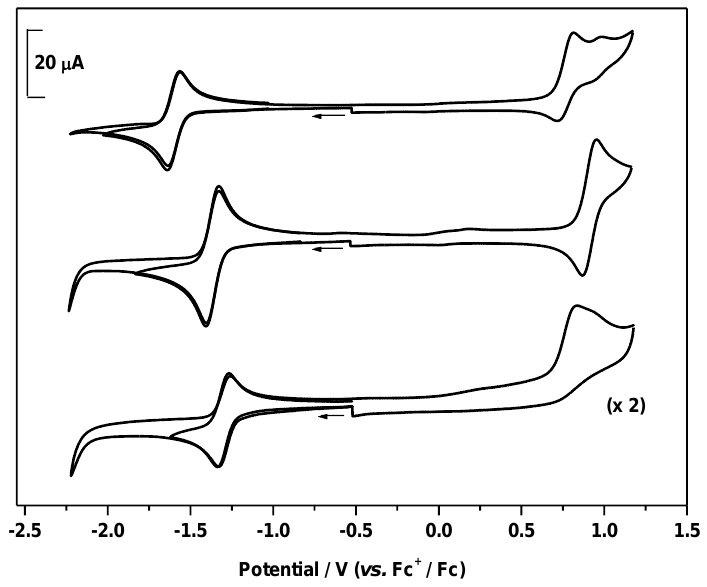
Figure 4. Cyclic voltammograms of 1 (upper traces), 2 (middle traces) and 3 (lower traces) at RT in CH 2 Cl 2 with [ n Bu 4 N][BF 4 ] (0.4 M) as supporting electrolyte.